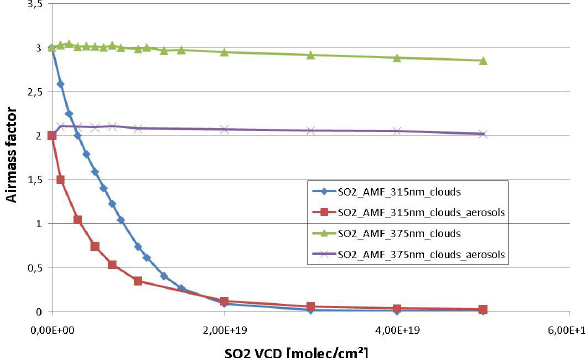
Fig. 6. Simulated SO 2 SCDs for 315nm versus SO 2 SCDs at 375nm for satellite remote sensing of the Kasatochi SO 2 plume on 8 August 2008 for two cases: without aerosols or with aerosol in- side the plume (optical depth of 3). In addition to the modelled SO 2 SCDs also the GOME-2 measurements are included in the figure. Only if aerosols are present in the plume, simulations and measure- ments are in agreement.